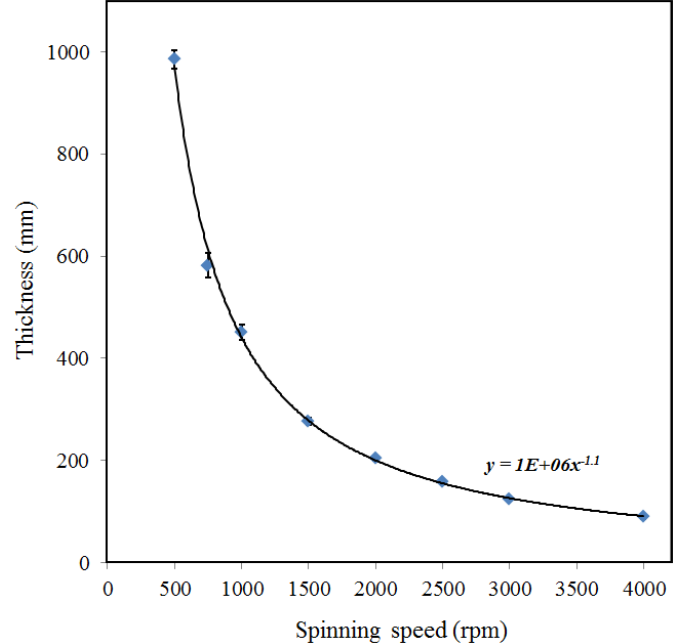
Figure 2. Relationship between spinning speed and PES membrane thickness.